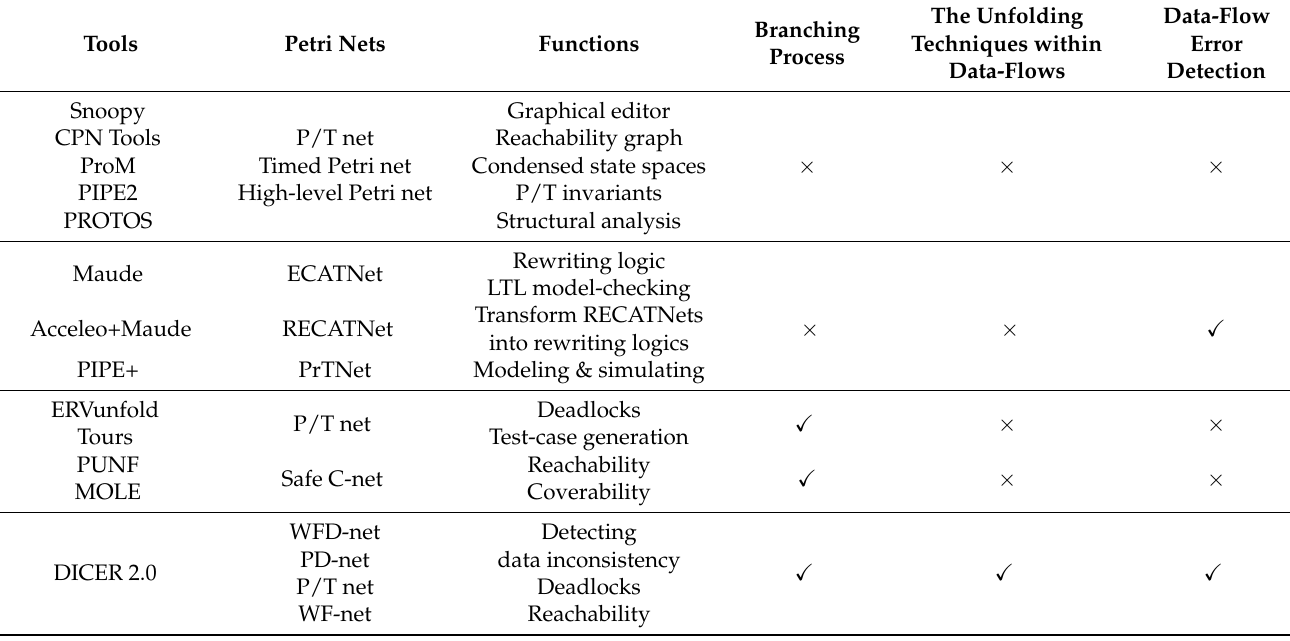
Table 1. The comparison between some Petri net